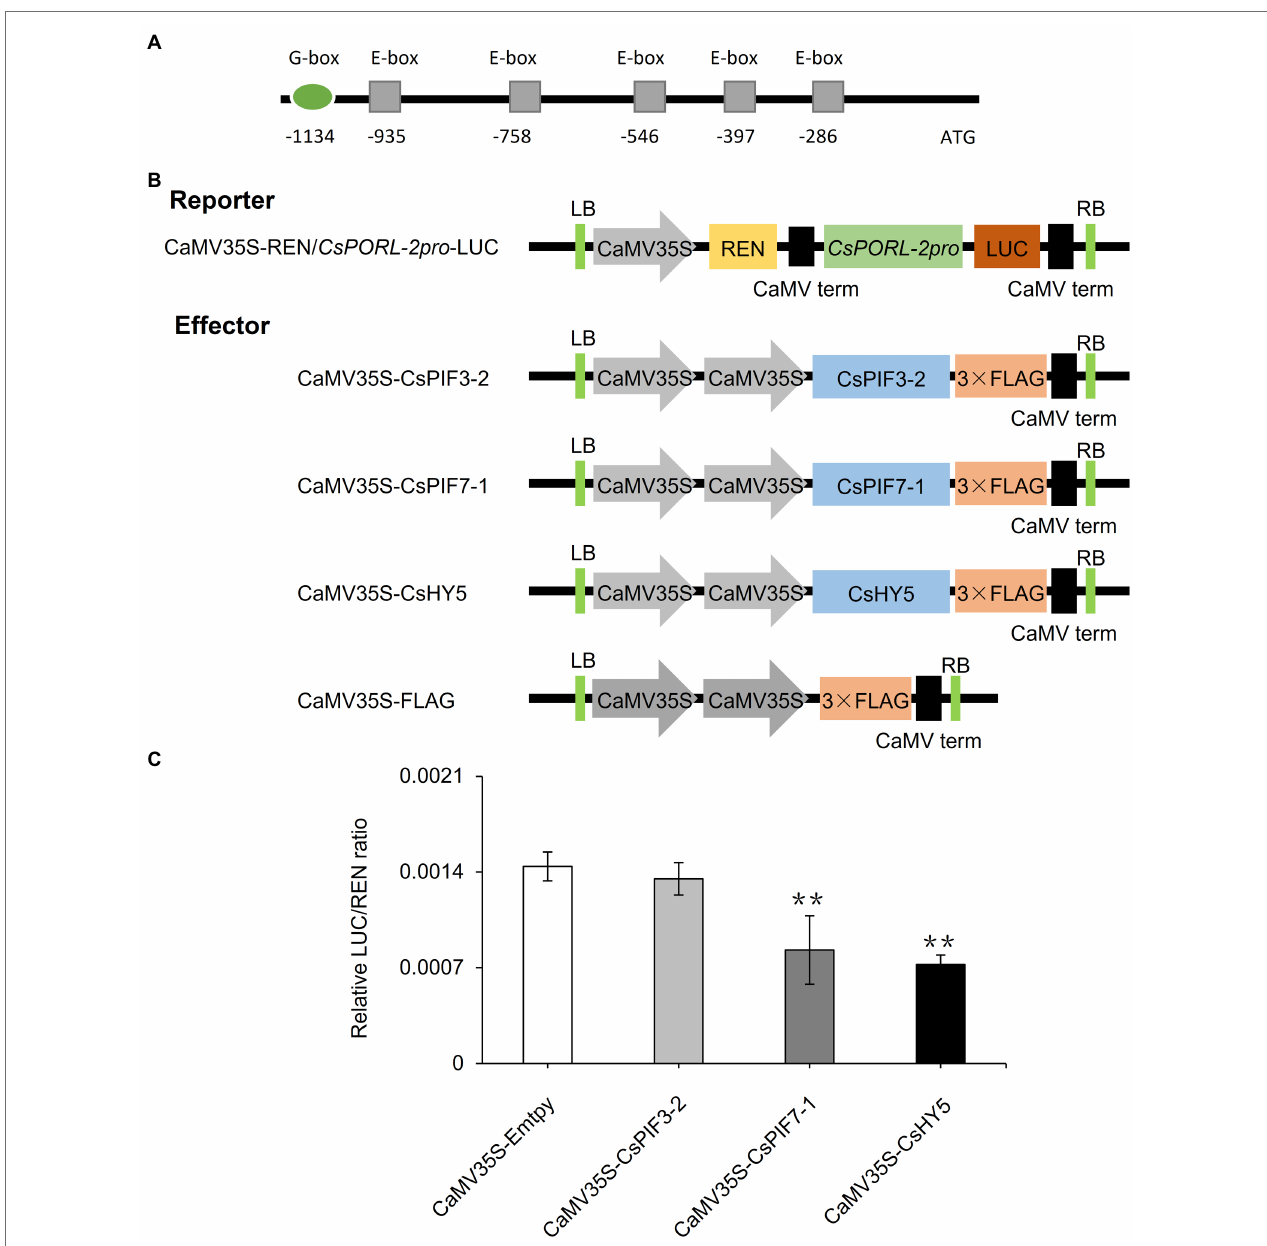
FIGURE 6 | Involvement of CsPIF3-2/7–1 and CsHY5 in regulating the expression of genes related to chlorophyll synthesis. (A) CsPORL-2 promoter element analysis. (B) Schematic representation of the double reporter and effector plasmids used in the dual-luciferase reporter assay. (C) CsPIF3-2, CsPIF7-1, and CsHY5 have transcriptional regulatory activity on CsPORL-2 promoter. The regulation of CsPORL-2 promoter by CsPIF3-2, CsPIF7-1, and CsHY5 was showed by the ratio of LUC to REN. Data are expressed as mean ± SD ( n = 3). ** p ≤ 0.01; and difference from empty-vector control